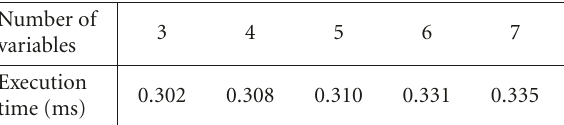
Figure 13: The relationship between average encoding time and distortion for video sequences in cluster